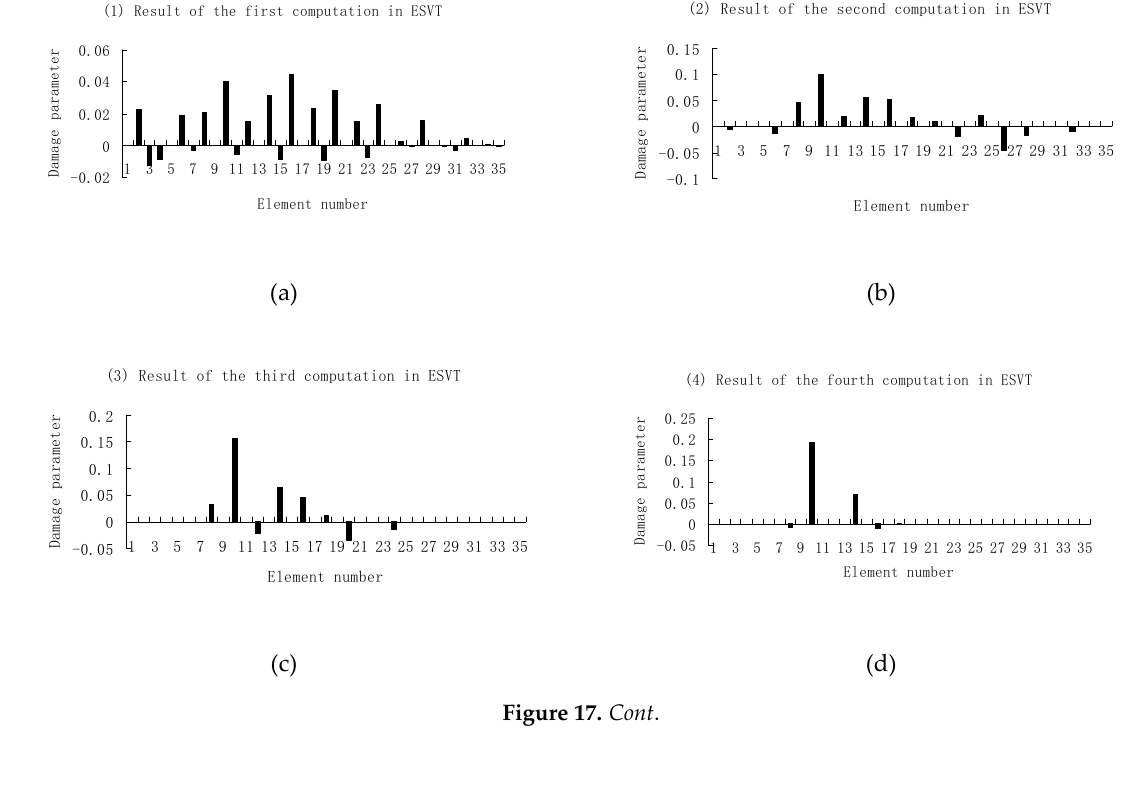
Figure 16. Damage evaluation results of the first to sixth computations in ESVT using the first four frequencies (element 10 had 20% stiffness reduction). ( a ) Result of the first computation in ESVT; ( b ) Result of the second computation in ESVT; ( c ) Result of the third computation in ESVT; ( d ) Result of the fourth computation in ESVT; ( e ) Result of the fifth computation in ESVT; ( f ) Result of the sixth computation in ESVT.